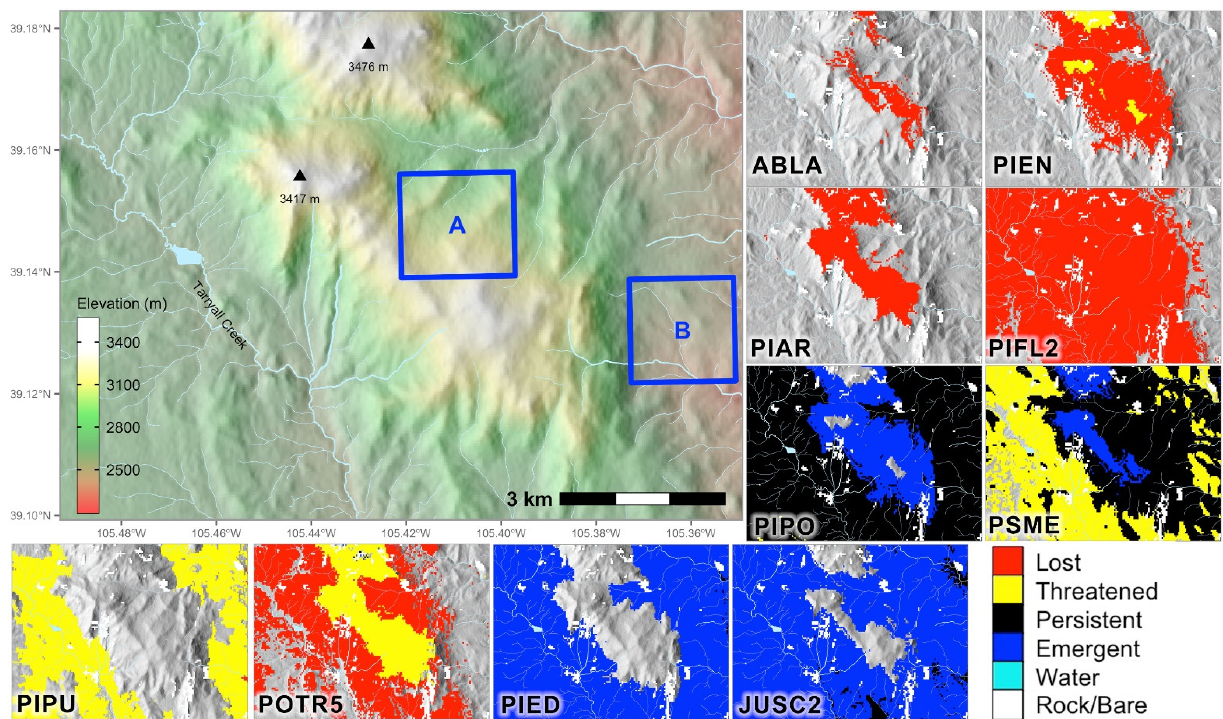
Figure 5. Two hypothetical project areas and change projections of the species suitable in the reference period or 2060. Project A is at relatively high elevation; project B at low elevation. The species maps encompass the full area of the first panel. Note that colors in the first panel (upper left) code elevation; colors in the species maps show the change classes.